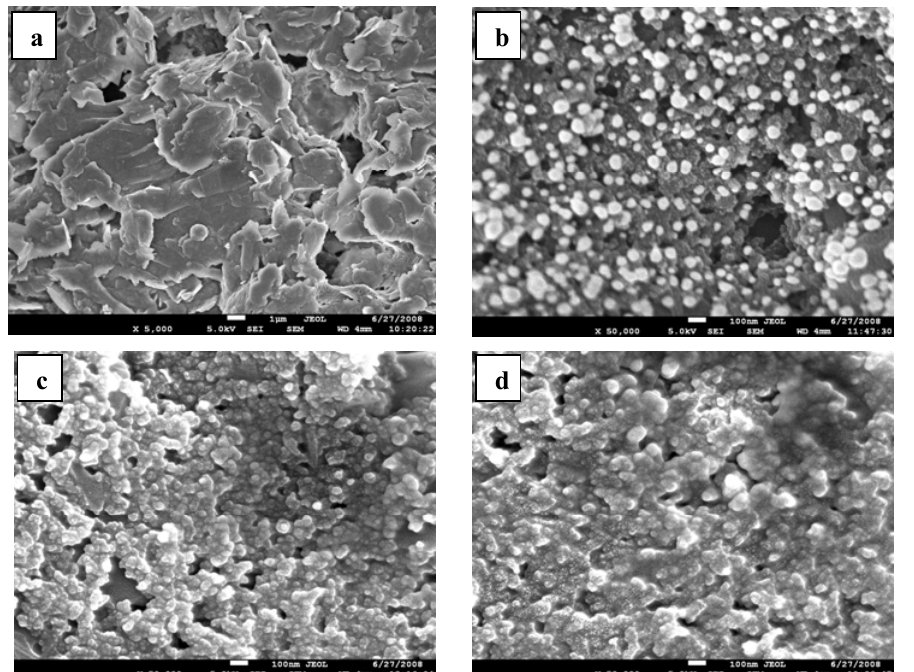
Figure 1. FE-SEM images on screen printed carbon electrodes (SPCE) (a) blank SPCE. (b) SPCE/AuNP. (c) SPCE/PPI (d) .